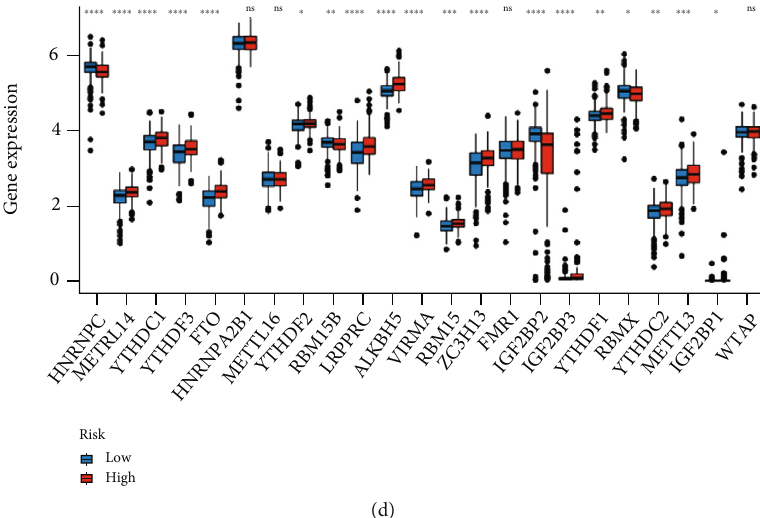
Figure 7: Immunity and gene expression. (a) Heatmap for immune responses based on 7 algorithms between high- and low-risk groups. (b) Expression of immune checkpoints in the high and low LPM_score groups. (c) ssGSEA for the association between immune cell subsets and related functions. (d) The expression of m6a-related genes in high and low LPM_score